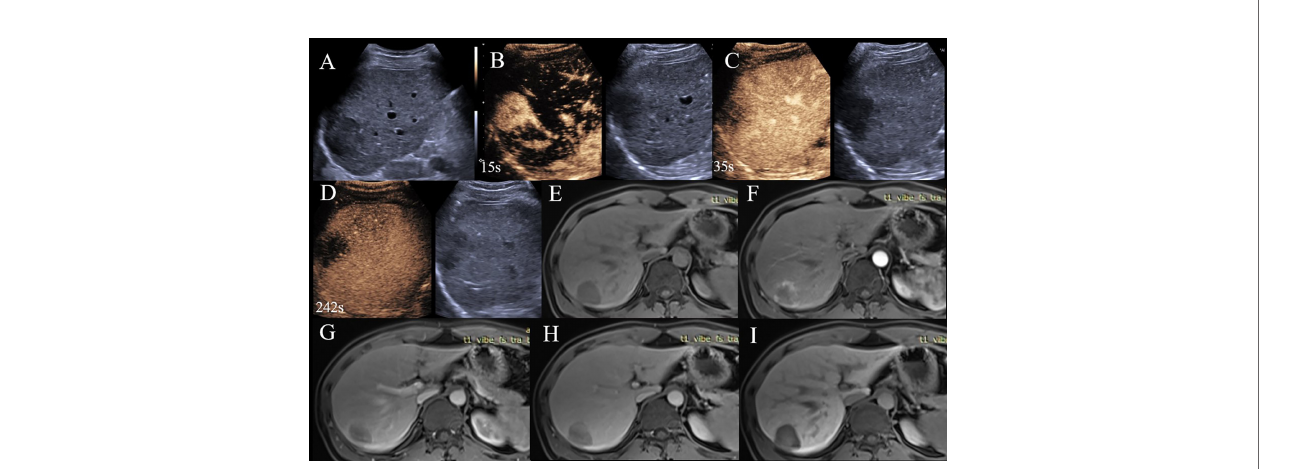
FIGURE 1 | A 36-year-old man with HBV related liver cirrhosis. Serologic data indicated AFP of 167 ng/ml and CA19-9 of 13.5 ng/ml. (A) A hypo echoic lesion located under the liver capsule with the size of 4.1×3.8cm. (B) The lesion displayed APHE on CEUE; (C) Early washout was observed at 35s after injection of contrast agent; (D) Washout was observed on delay phase, the lesion was categorized as CEUS LR-M. (E) The lesion displayed hypointensity on EOB-MRI; (F) Rim-APHE was observed on EOB-MRI; (G, H) Delayed enhancement was also observed on portal and transitional phases; (I) The lesion showed hypointensity on hepatobiliary phase, the lesion was EOB MRI LR-M. The fi nal diagnosis was